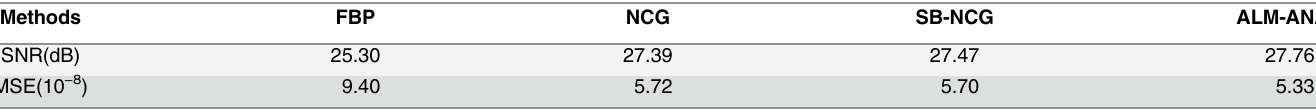
Table 1. SNRs and MSEs of the images reconstructed by four different